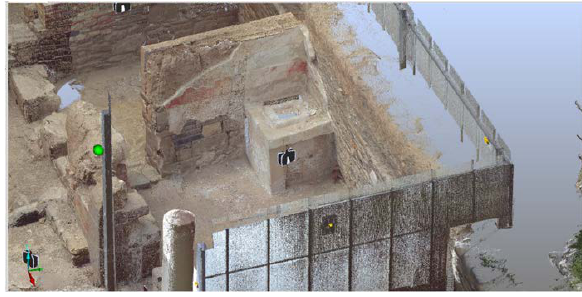
Figure 11. A detail of scan and targets positions. The point cloud processing was done with Scene package. The scanner targets residuals.